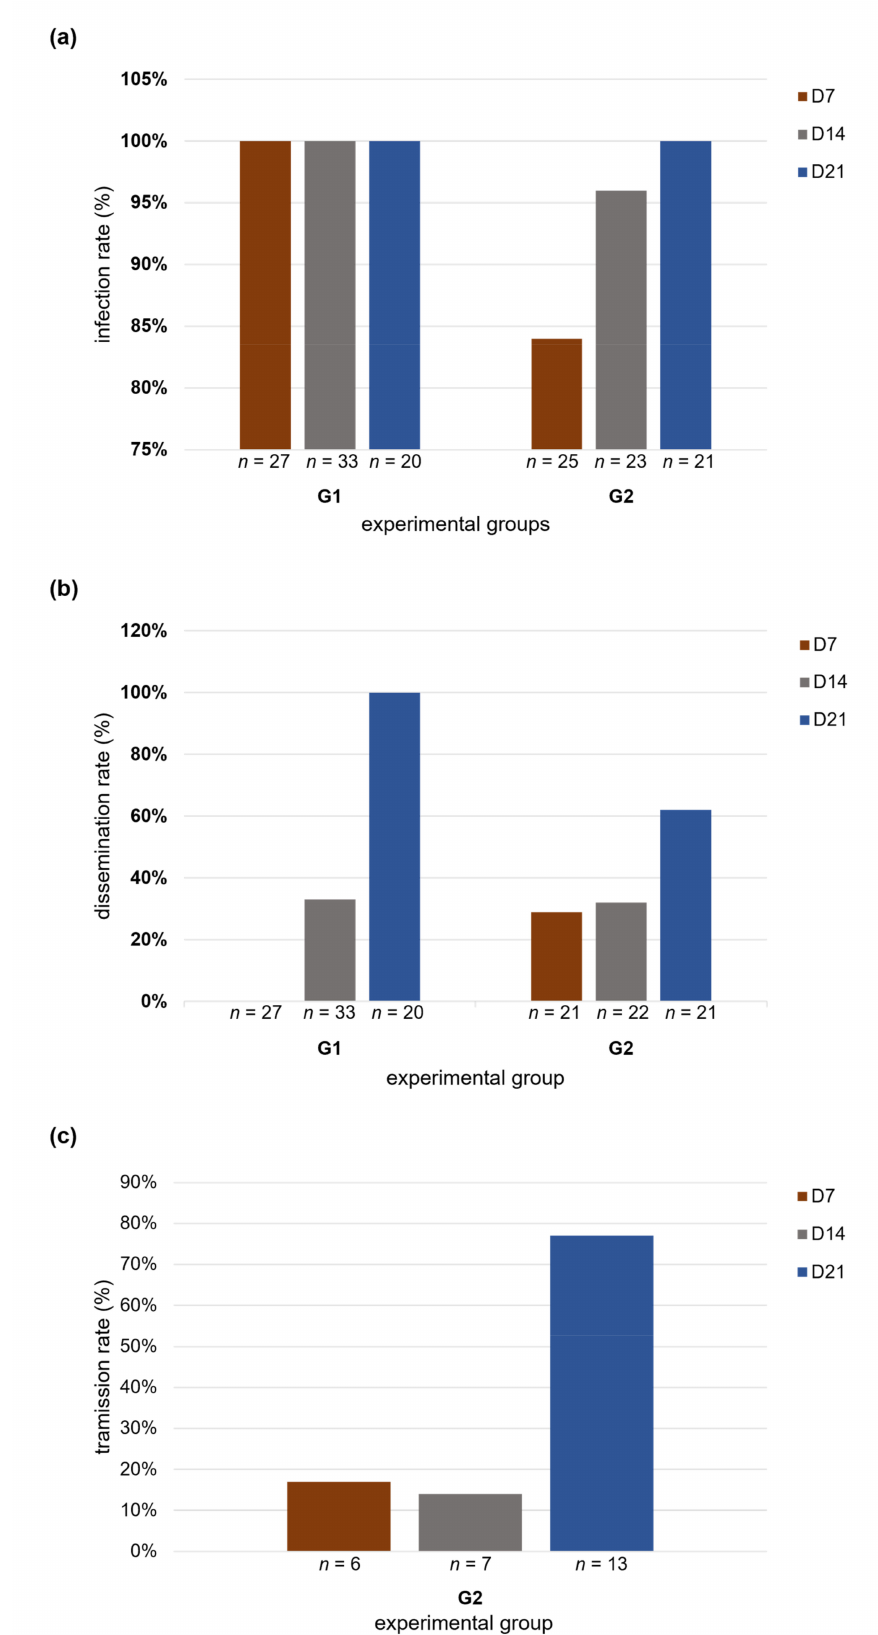
Figure 4. Percent parameters of vector competence of Culex quinquefasciatus strains from the